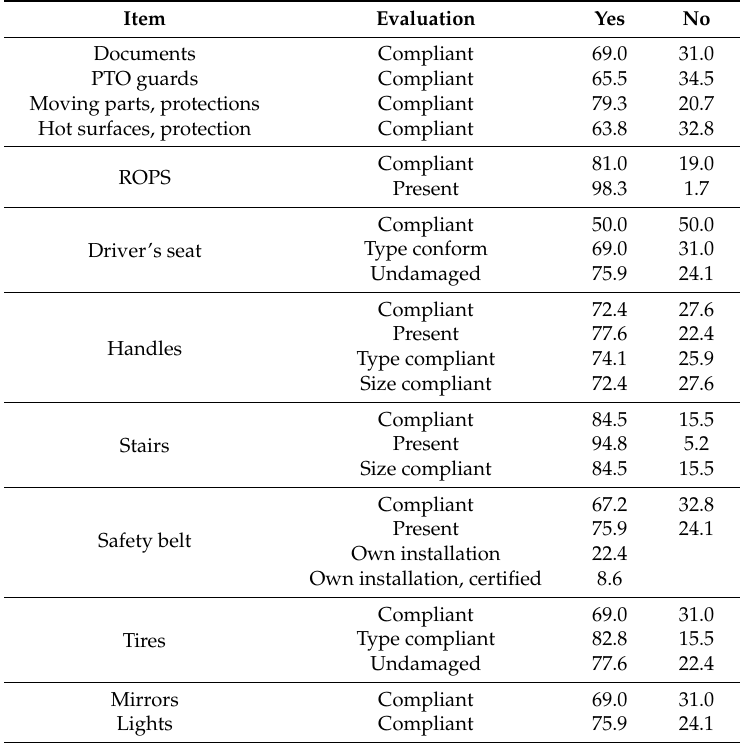
Table 9. Compliance with safety requirements (% of all tractors). Study-derived technical